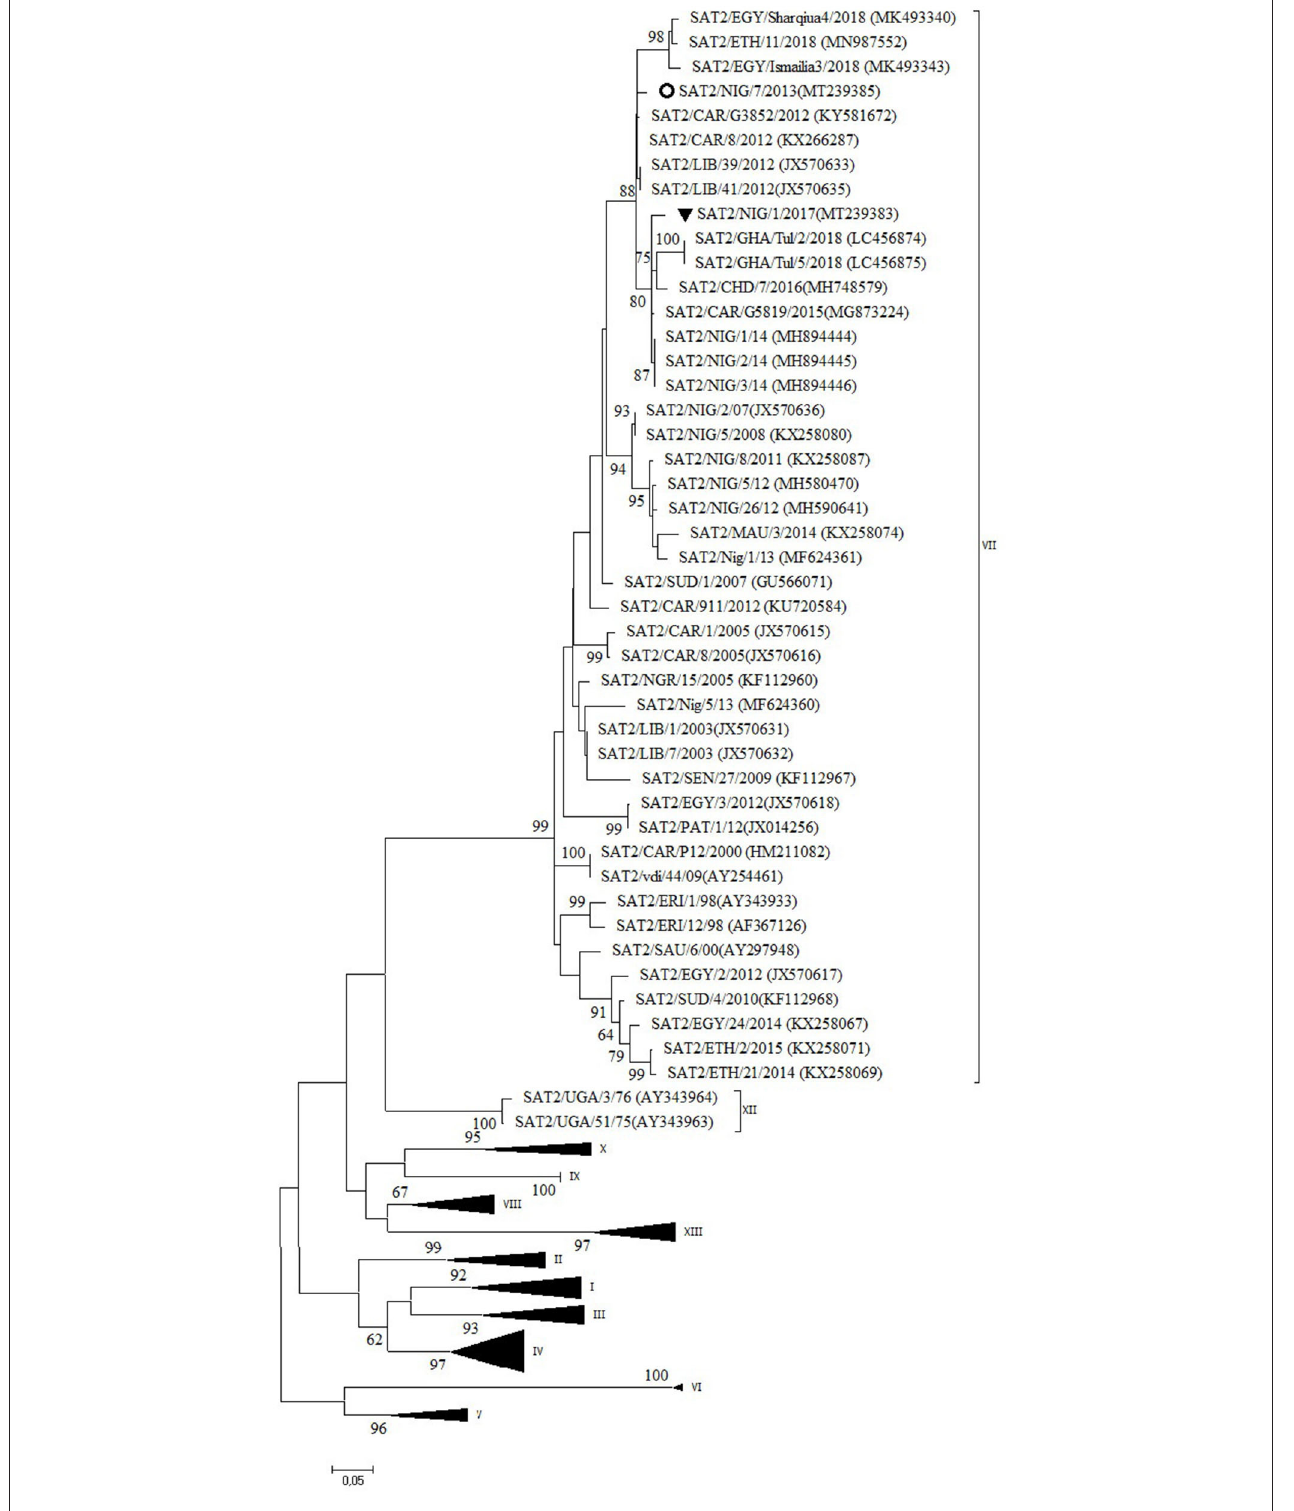
FIGURE 5 | VP1 phylogenetic tree for foot-and-mouth disease virus (FMDV) serotype Southern African Territories (SAT)2 inferred using the maximum likelihood method based on the Tamura-Nei model. Branch lengths indicate the number of substitutions per site. Bootstrap values ≥ 60% are indicated at the nodes. Novel Nigerian FMDV from this study from Plateau is indicated with and from Abuja FCT with ◦ .